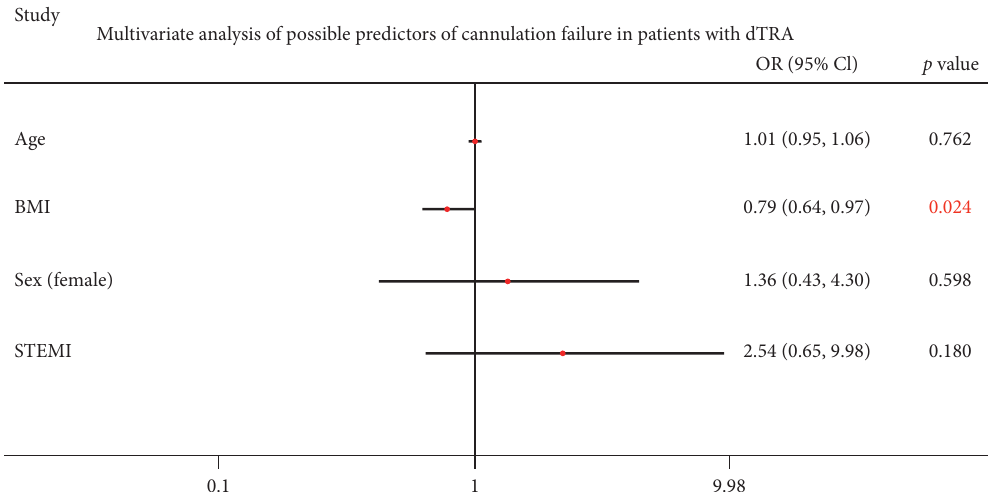
Figure 4: Multivariate analysis of possible predictors of cannulation failure in patients with